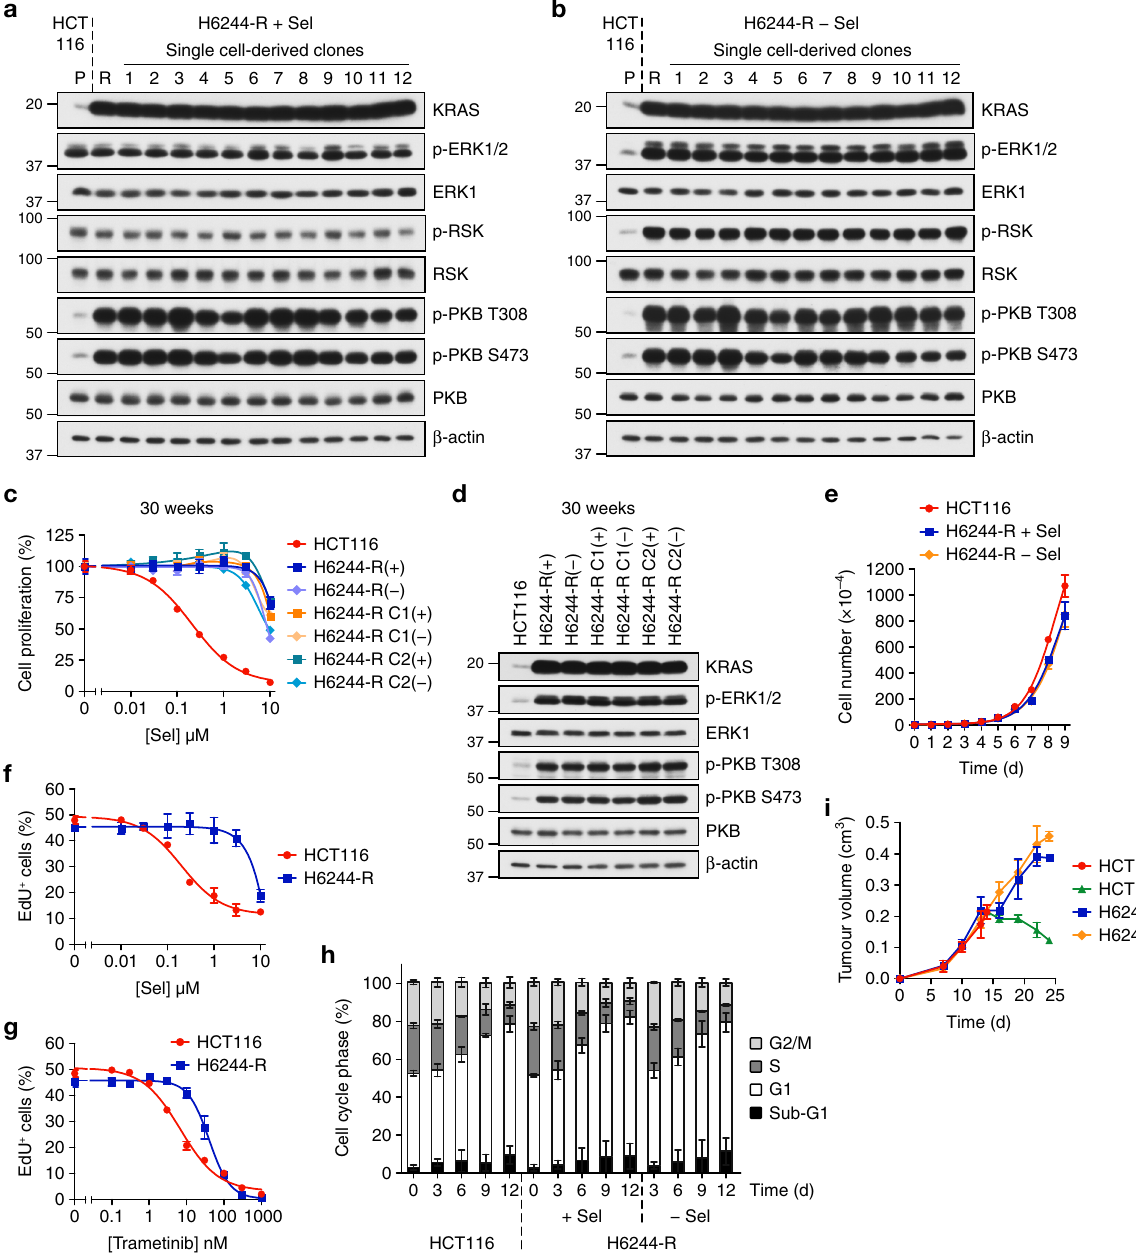
Fig. 6 Acquired MEKi resistance driven by KRAS G13D ampli fi cation is not reversible. a , b Non-clonal HCT116 cells with acquired resistance to selumetinib (H6244-R cells, R) and 12 single-cell clone derivatives (1 – 12) were treated with 2 μ M selumetinib (Sel) ( a ) or selumetinib-free medium ( b ) for 24 h. Parental HCT116 cells (P) were treated in parallel with selumetinib-free medium. Lysates were western blotted with the indicated antibodies. c , d Following 30 weeks culture in the presence ( + ) or absence (HCT116, ( − )) of 2 μ M selumetinib, cells were treated as indicated with selumetinib (Sel) for 24 h, and DNA synthesis assayed by [ 3 H]thymidine incorporation ( c ), or incubated in selumetinib-free medium for 24 h and lysates western blotted with the indicated antibodies ( d ). H6244-R C1 and C2 are single-cell clone derivative cell lines of H6244-R. Results ( c ) are mean ± SD of cell culture triplicates and normalized to control for each cell line. e HCT116 and H6244-R cells were treated with either 2 μ M selumetinib (H6244-R + Sel) or DMSO only (HCT116, H6244-R − Sel) and cell numbers counted over 9 days. Results are mean ± SD of cell culture triplicates, representative of three independent experiments. f , g HCT116 and H6244-R cells were treated as indicated with selumetinib (Sel) ( f ) or trametinib ( g ) for 72 h. Percent EdU-positive (EdU + ) cells was determined by high-content image analysis. Results are normalized to HCT116 control. h HCT116 and H6244-R cells were treated with either 2 μ M selumetinib (H6244-R + Sel) or DMSO only (HCT116, H6244-R − Sel) for the indicated times. Cell cycle distribution was determined by fl ow